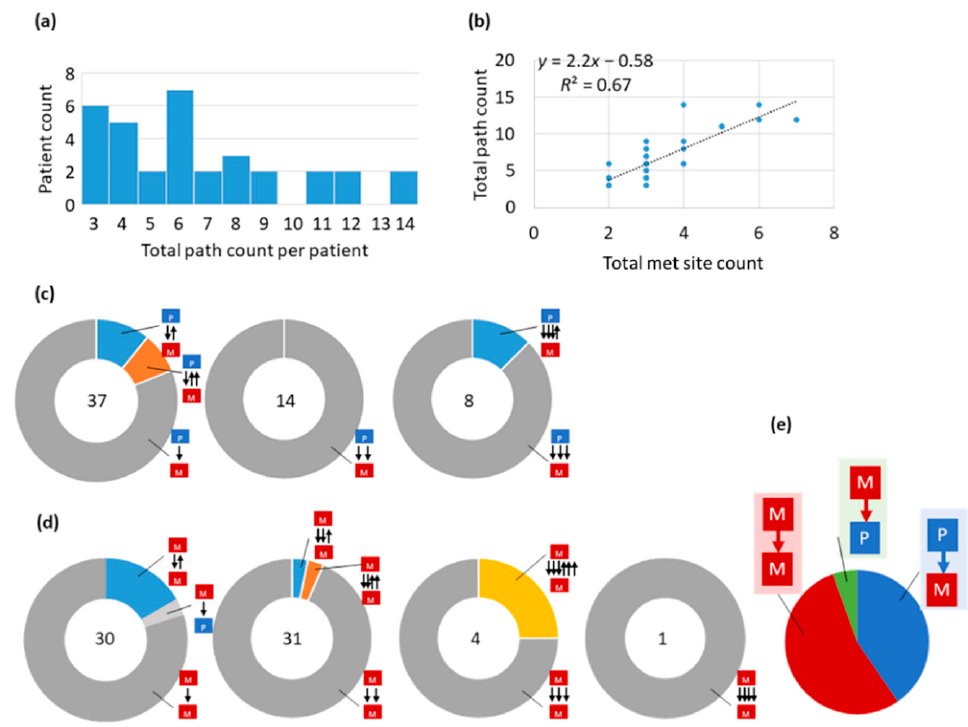
Figure 6. Distribution of clone migrations for the Zhao cohort dataset. ( a ) Histogram of migration path counts in patients. ( b ) Linear regression of the number of migrations against the number of metastatic sites sampled. ( c ) The number (center) and proportion of migrations of clones from primary tumors. Each black arrow indicates a seeding event. The direction of an arrow represents the orientation of the seeding event. Multiple arrows with the same direction indicate polyclonal seeding events, where the number of arrows corresponds to the number of clones migrated. ( d ) The number (center) and proportion of migrations of clones from metastatic tumors of tumor pairs. ( e ) Proportions of path types. To infer seeding events, we first built clone phylogenies from sequence data using CloneFinder, and then each clone phylogeny was analyzed using